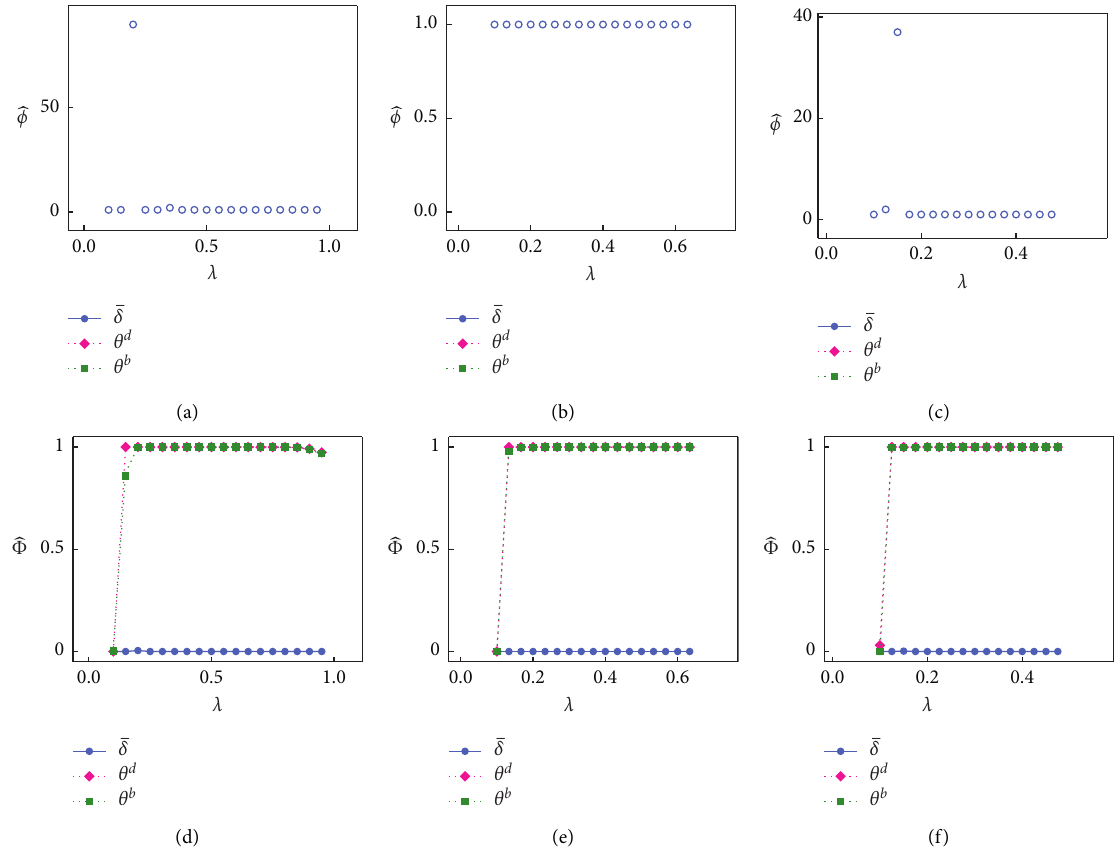
Figure 2: The numerical ranks of optimal latent edges on the SF network. The numerical rank of the optimal latent edge scored by δ versus λ when (a) β � 1, (b) β � 1 . 5, and (c) β � 2. The normalized numerical rank 􏽢 Φ of the optimal latent edge scored by δ (blue circles), product θ d (pink diamonds), or θ b (green squares) versus λ when (d) β � 1, (e) β � 1 . 5, and (f) β �